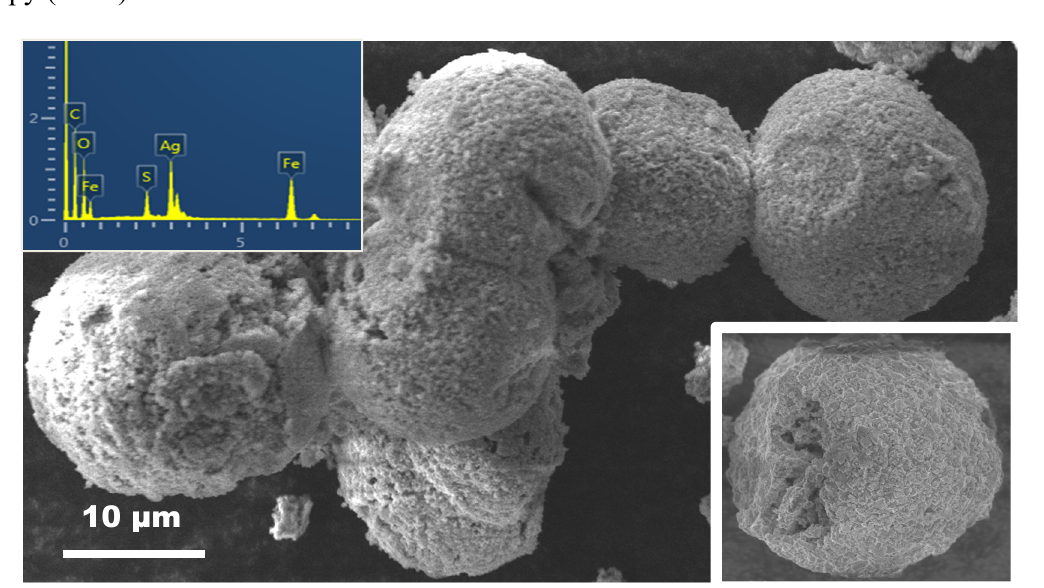
Figure 1. Scanning electron microscopy (SEM) micrograph showing the morphology of Ag@ α -Fe 2 O 3 composite. In the inset are shown one single agglomerate and the energy-dispersive X-ray spectrum (EDX)